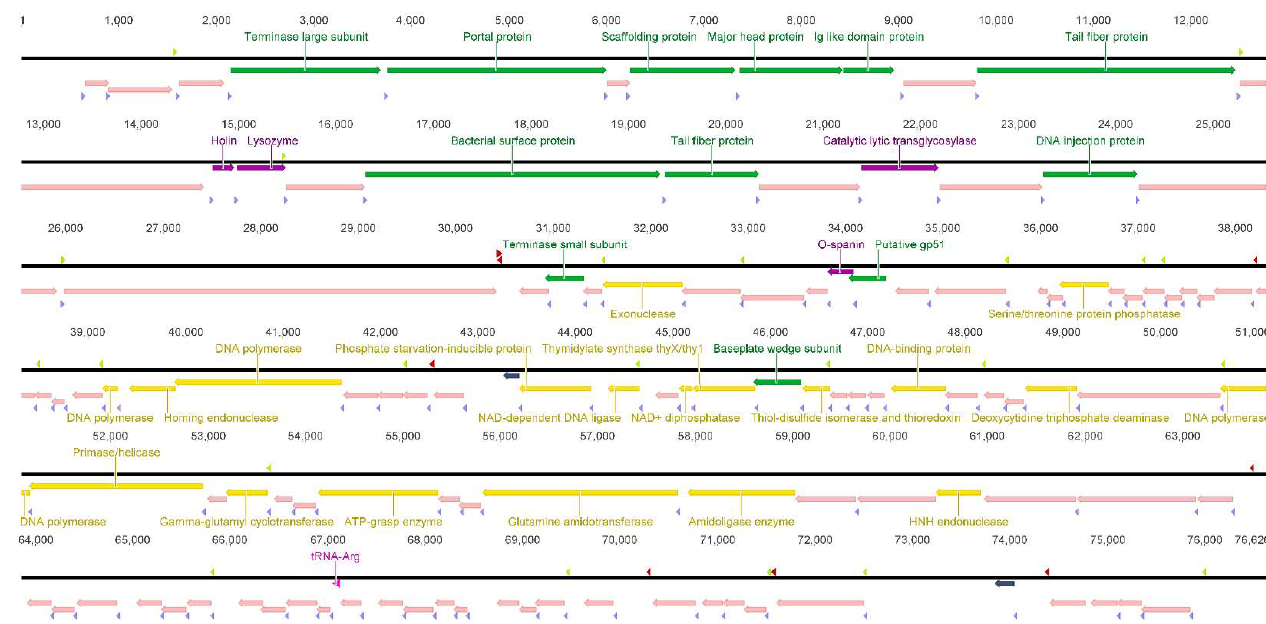
Figure 3. Genome organization with Prokka-predicted ORFs. Direction and annotation colored according to the function group of the genes: yellow, DNA metabolism; light pink, hypothetical proteins; dark gray, proteins with no significant similarity; green, structural proteins; dark purple, lysis related proteins; and pink, tRNA. Transcripts were identified by SoftBerry BROM and PhagePromoter on the Galaxy@GalaxyDockerBuild platform as starting at the promoter regions (light green) and ending at the rho-independent transcription terminators (red), which were identified using ARNold. Putative ribosomal binding sites (light purple) were identified in untranslated regions upstream of the ORFs. Genome visualization was obtained using Geneious software version 6.1.8. See Section 2 for references to the computer programs used.